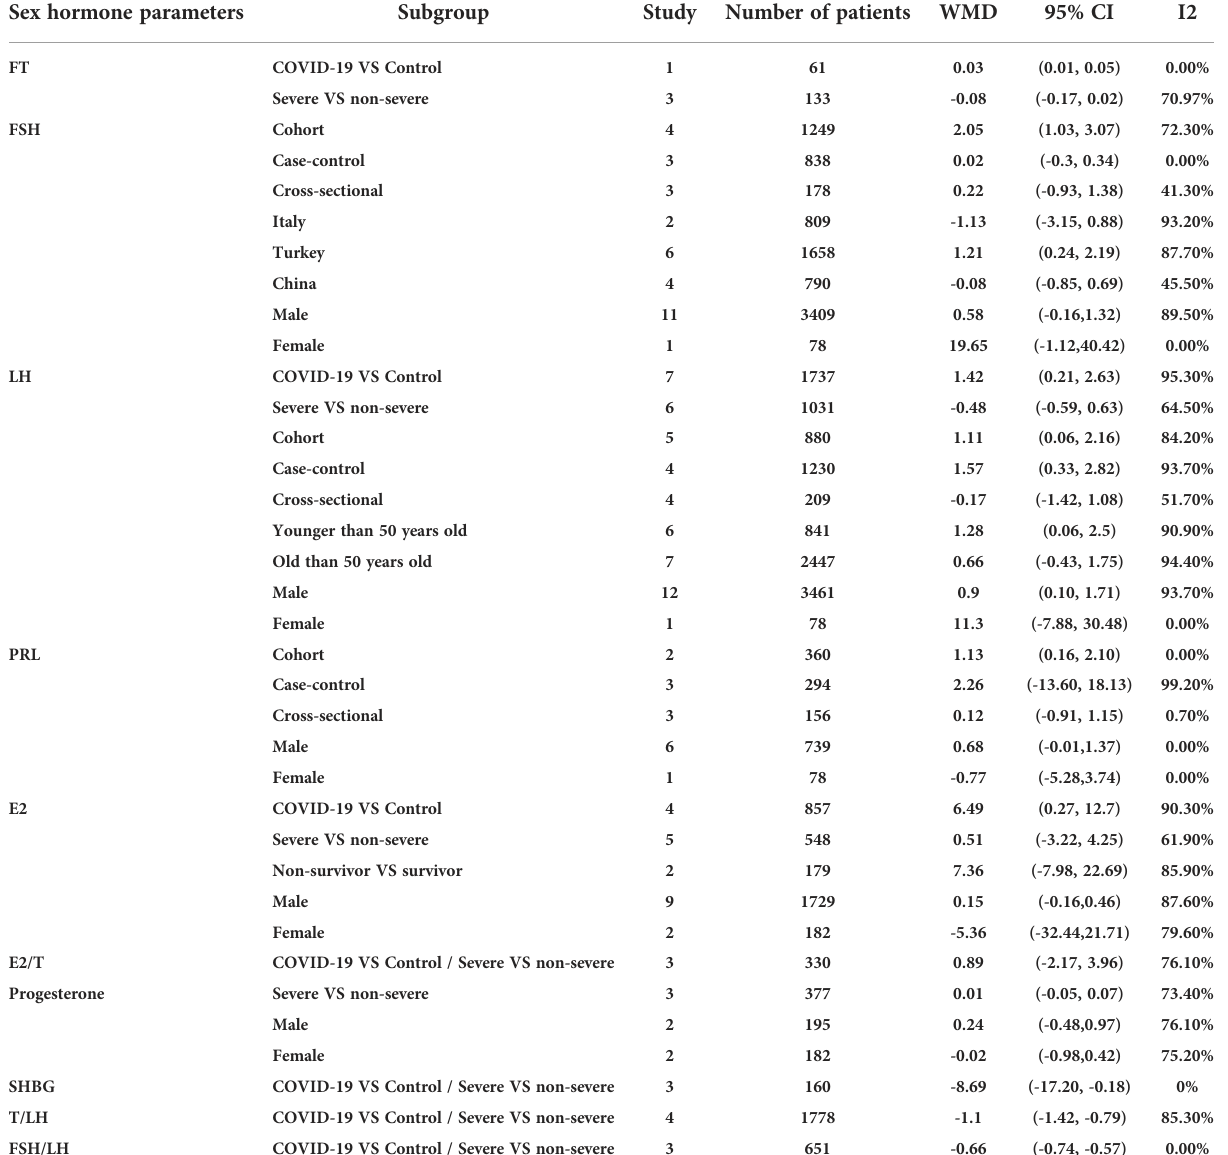
TABLE 2 Sex hormone levels. Sex hormone parameters